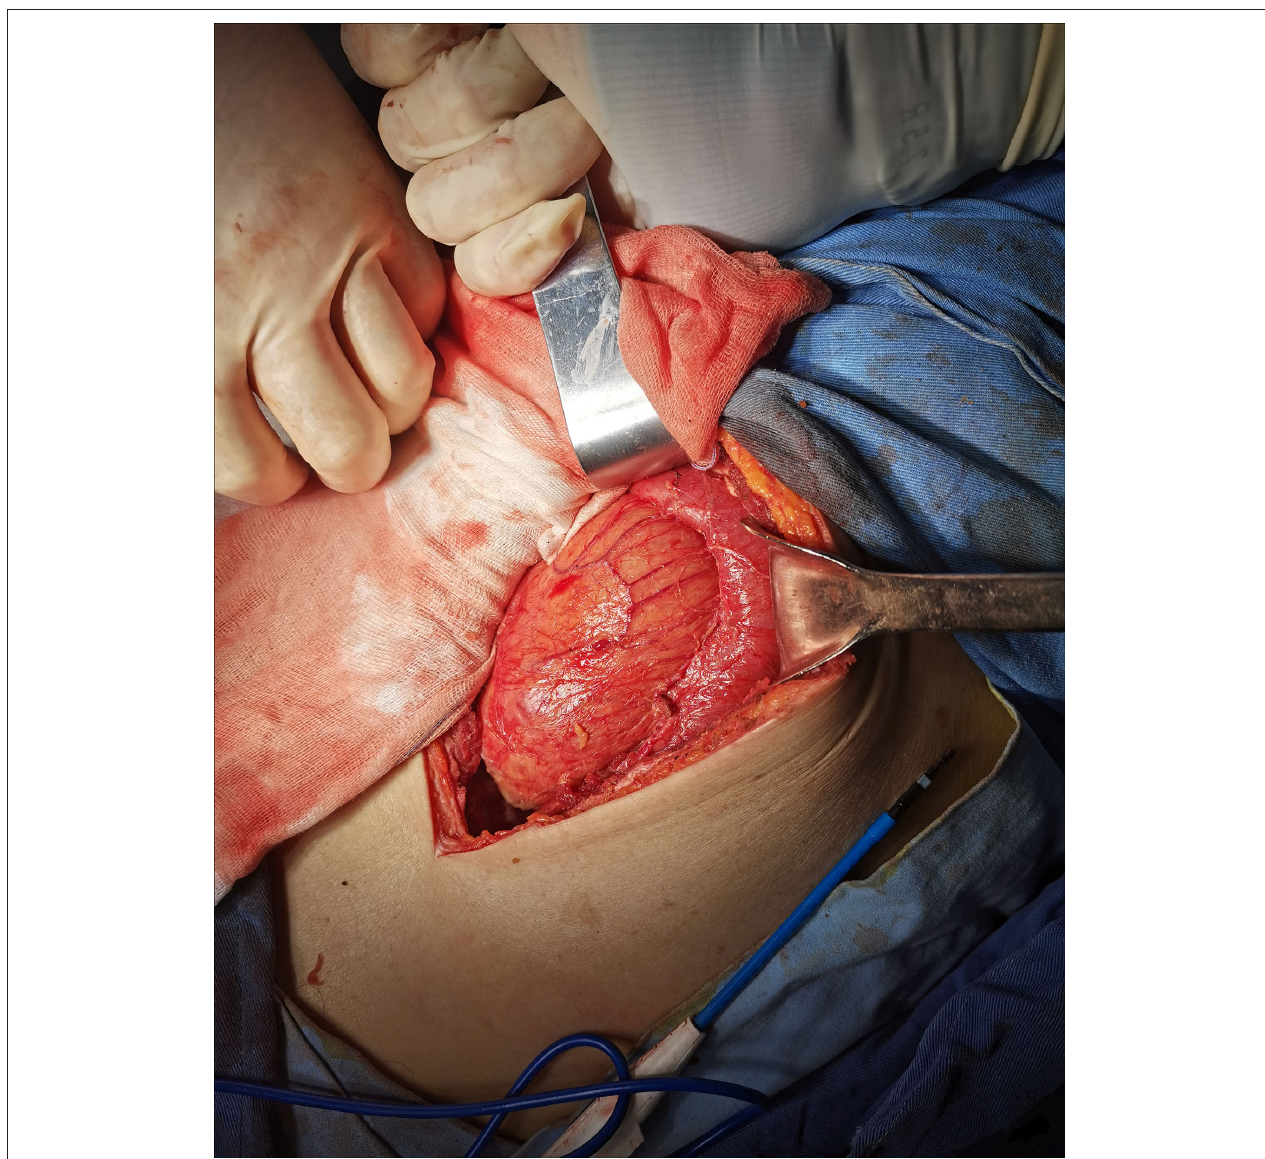
FIGURE 2 | The end of the right lower abdominal ileum was found to be conglutinated and twisted into a mass.